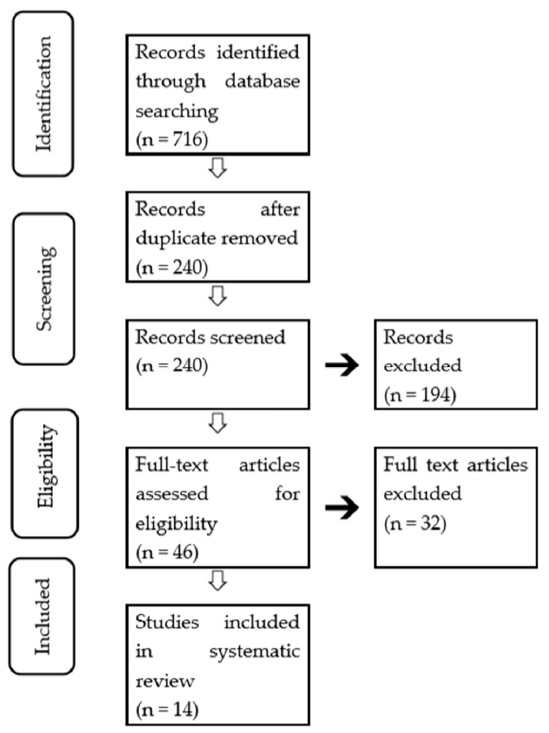
Figure 1. Flow diagram of the literature search.